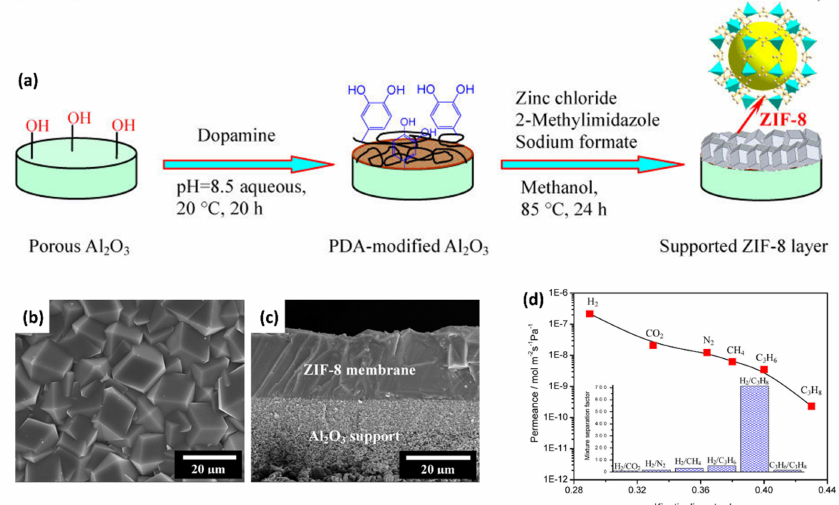
Figure 4. ( a ) Scheme of in situ synthesis of ZIF-8 membranes using dopamine as covalent linker between ZIF-8 layer and Al 2 O 3 support. ( b ) Top view and ( c ) cross-section SEM images of the ZIF-8 membrane. ( d ) Single gas permeances of different gases through the ZIF-8 membrane prepared on PDA-modified Al 2 O 3 support at 150 ◦ C as a function of kinetic diameter